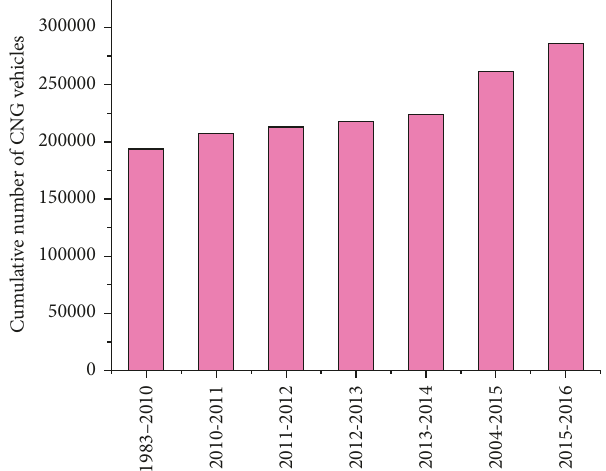
Figure 5: Growth of CNG vehicles in